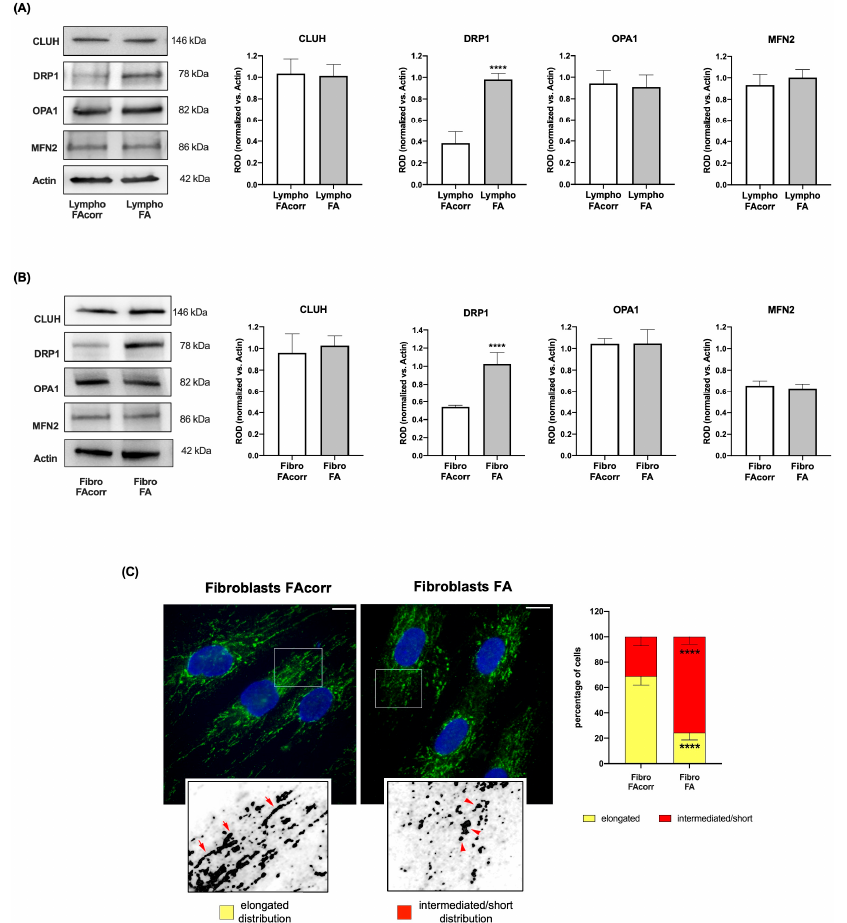
Figure 4. Expression levels of mitochondrial fusion and fission markers in lymphoblasts and fibroblasts mutated for the FANC-A gene. Lymphoblast ( A ) and fibroblast ( B ) cell lines expression of proteins involved in mitochondrial dynamics. WB signals of CLUH (mitochondrial biogenesis), DRP1 (mitochondrial fission), OPA1, MFN2 (mitochondrial fusion), and Actin (housekeeping protein used for signals normalization). For all the densitometry graphs, protein expression levels were normalized on the housekeeping signal, revealed on the same membrane. ( C ) Confocal imaging of FAcorr and FA fibroblasts stained with antibody against TOM20 (green) and DAPI (blue) to show the mitochondrial reticulum and nuclei, respectively. White scale bars correspond to 10 µ m. The higher magnification insert corresponds to the area enclosed by the white square and is an example of mitochondrial network distribution. Fibroblasts were scored depending on the morphology of most of their mitochondrial population as elongated or intermediated/short. Results reported in the histogram on the right show that FA fibroblasts exhibited more often intermediated/short and less elongated mitochondria compared to FAcorr cells. Data are reported as mean ± SD. Histograms and WB signals are representative of at least three independent experiments. Statistical significance was tested with an unpaired t -test; **** represents a significant difference for p < 0.0001 between FA cells and FAcorr cells used as